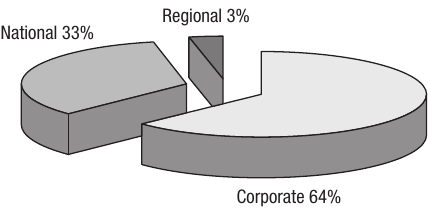
Fig. 4. Three levels that SWOT analysis has been used for